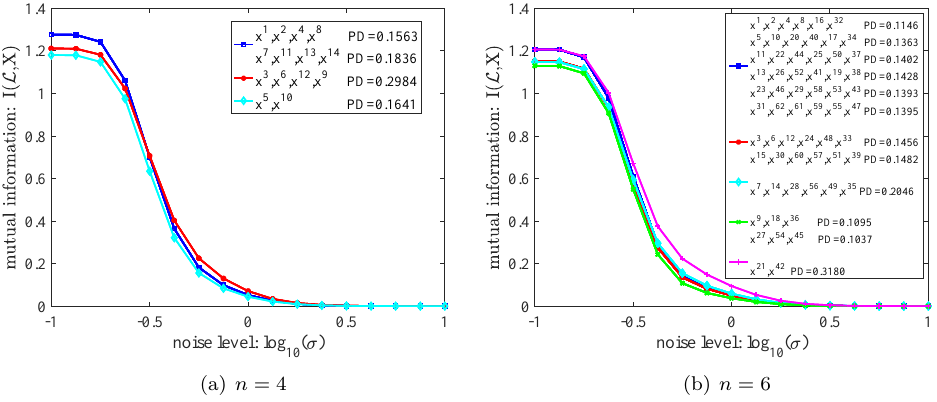
Figure 5: Mutual information of monomial functions for d =